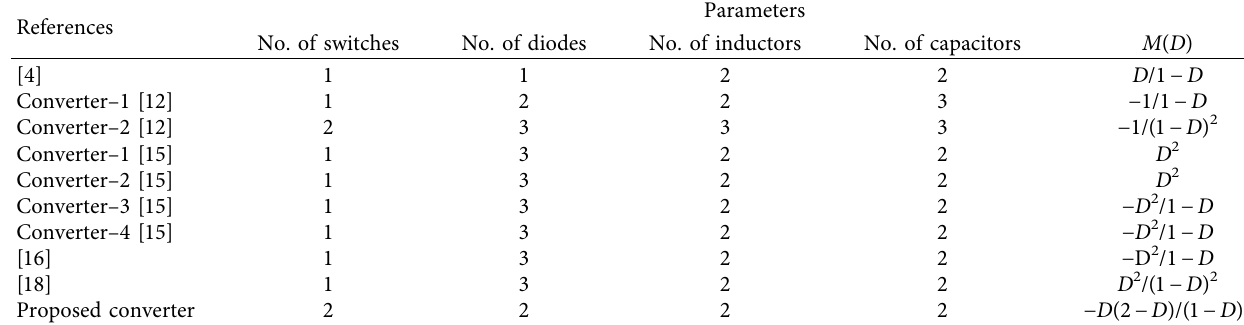
Table 1: Comparisons with Various Negative Output Topologies.